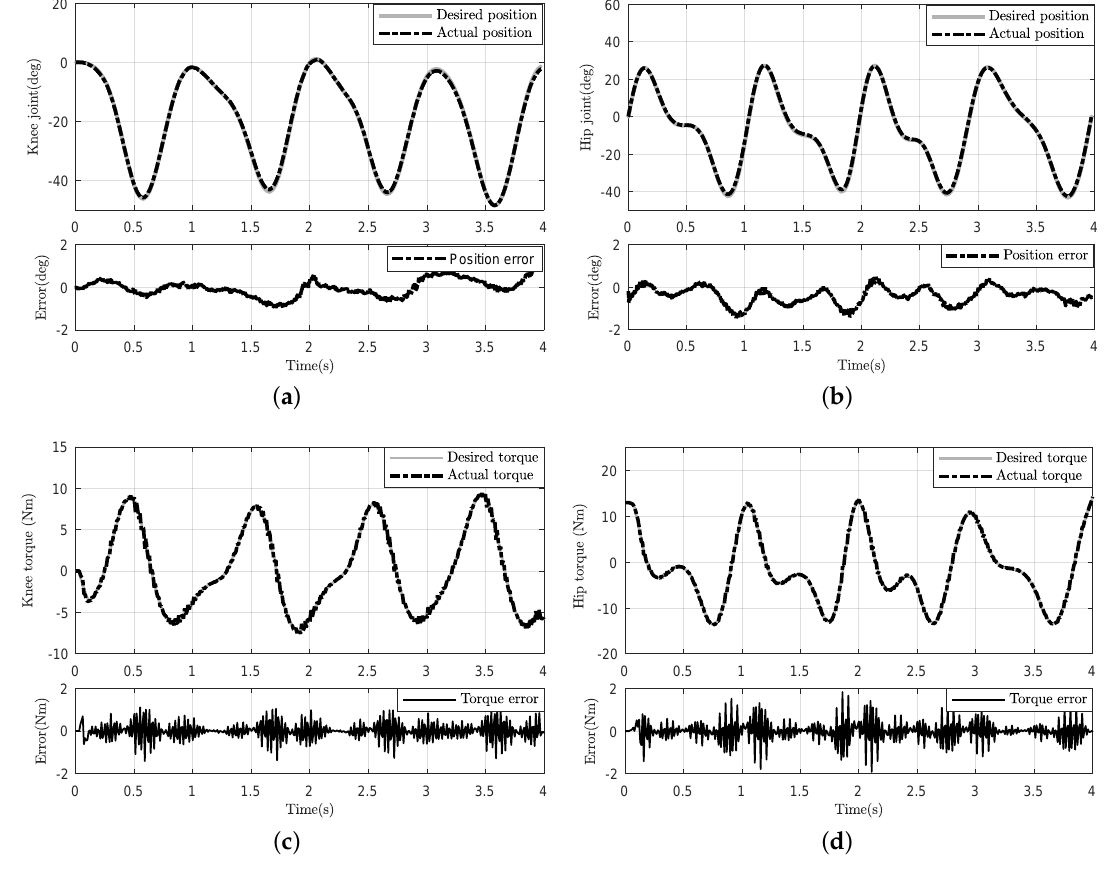
Figure 15. Experiment with a human subject. ( a ) Knee joint tracking and corresponding tracking error; ( b ) hip joint tracking and corresponding tracking error; ( c ) desired torque and actual torque of knee joint; ( d ) desired torque and actual torque of hip joint. Table 6. RSME comparison of three